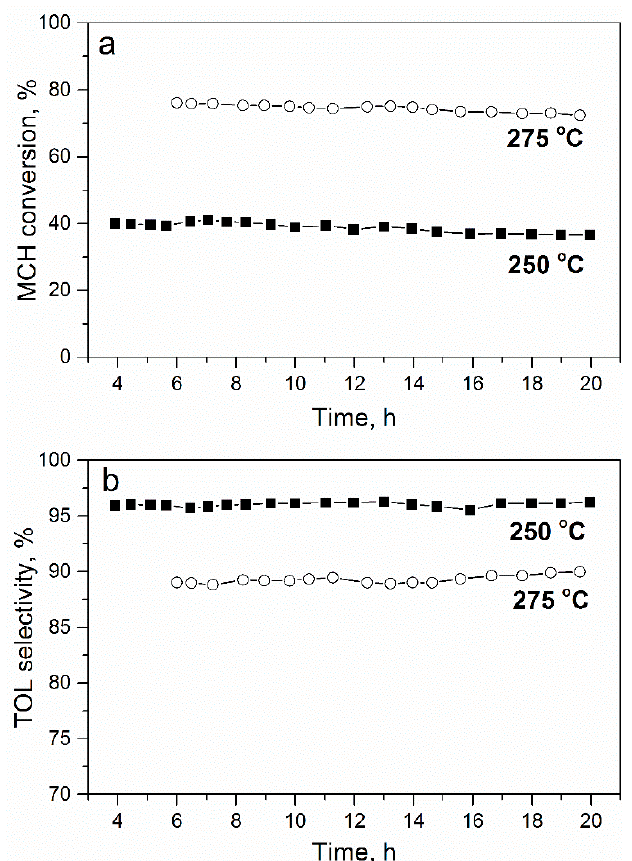
Figure 5. Methylcyclohexane (MCH) conversion ( a ) and toluene (TOL) selectivity ( b ) as a function of time over pCu_Ni80Cu20-SiO 2 catalyst. Reaction conditions: T = 250 and 275 °C, P = 0.1 MPa, m cat = 1.00 g, H 2 /Ar molar ratio equal to 1, gas feed rate of 400 mL/min, liquid feed rate of 6 mL/h.